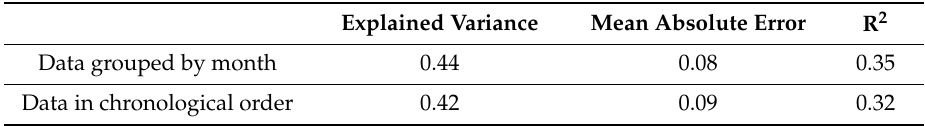
Table 3. Explained variance, R 2 , and Mean Absolute Error resulting from the support vector regression between Net leaf production and apparent